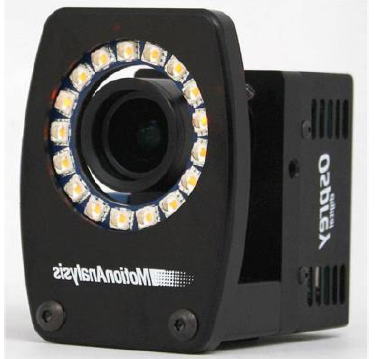
Figure 3. Camera system (Eagle-4). Figure 2. Example of measuring the walking characteristics of the elderly.